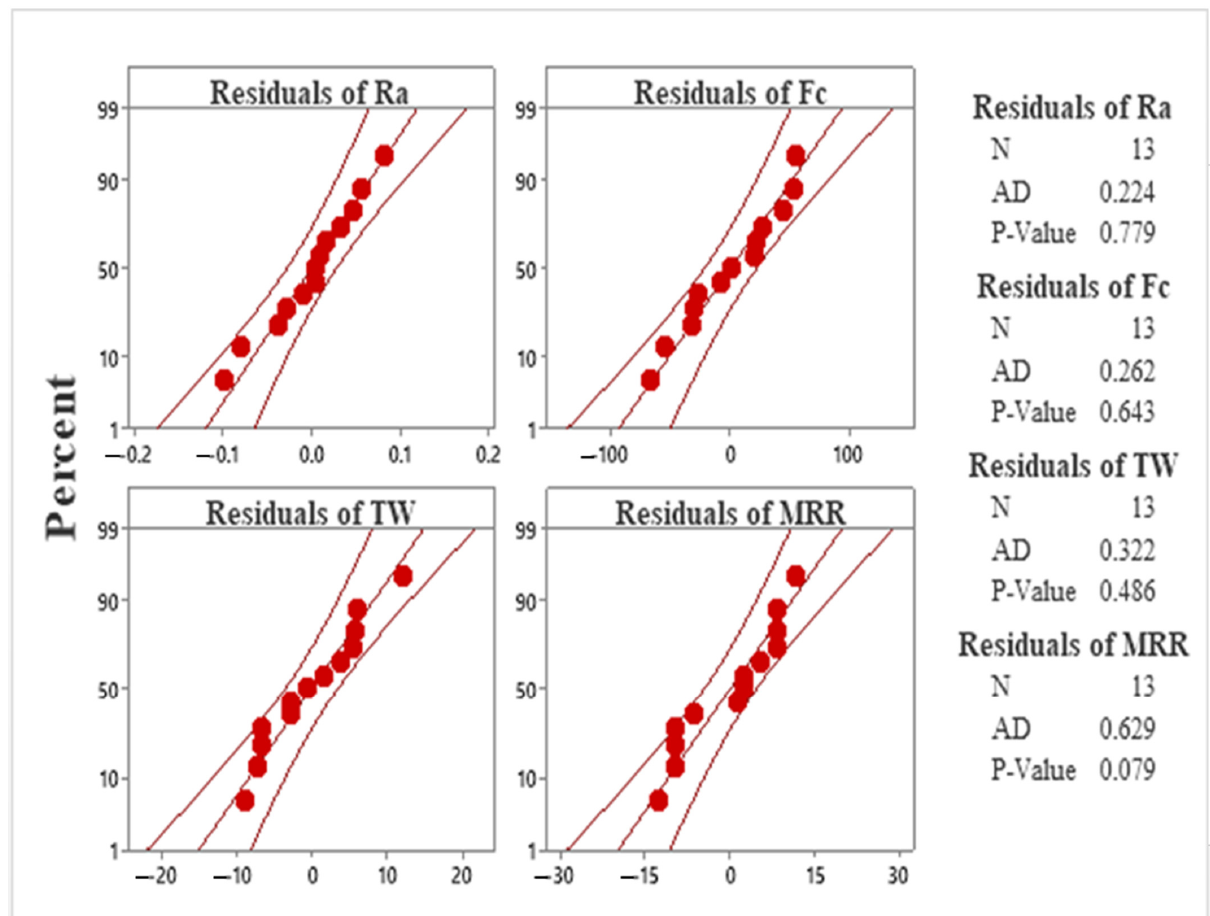
Figure 5. Normal probability plots of residuals for surface roughness, cutting forces, tool wear, and material removal rate. material removal